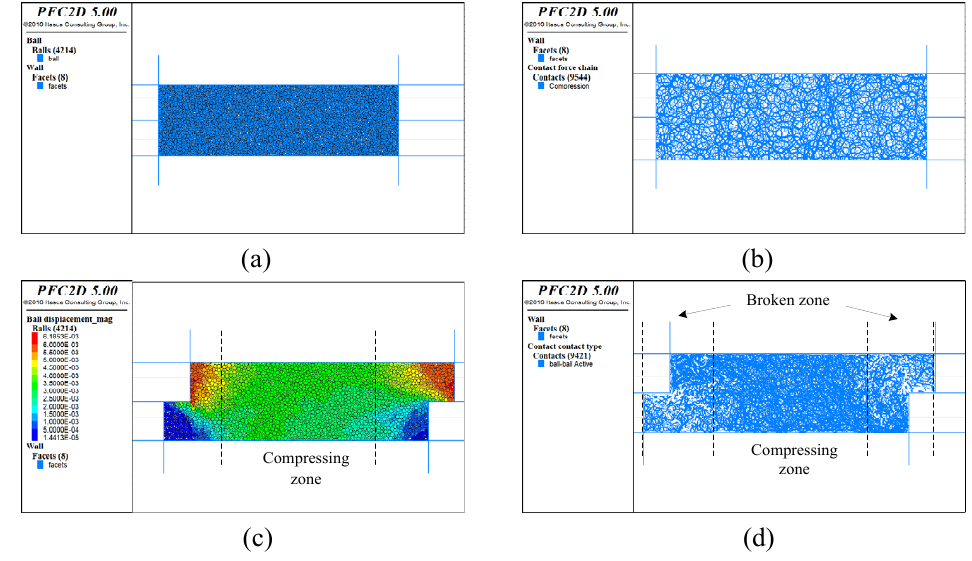
Figure 14. Details of DEM direct shear model: ( a ) soil displacement at the beginning of shear; ( b ) contact bond at the beginning of shear; ( c ) soil displacement at the end of shear; ( d ) contact bond at the end of shear.